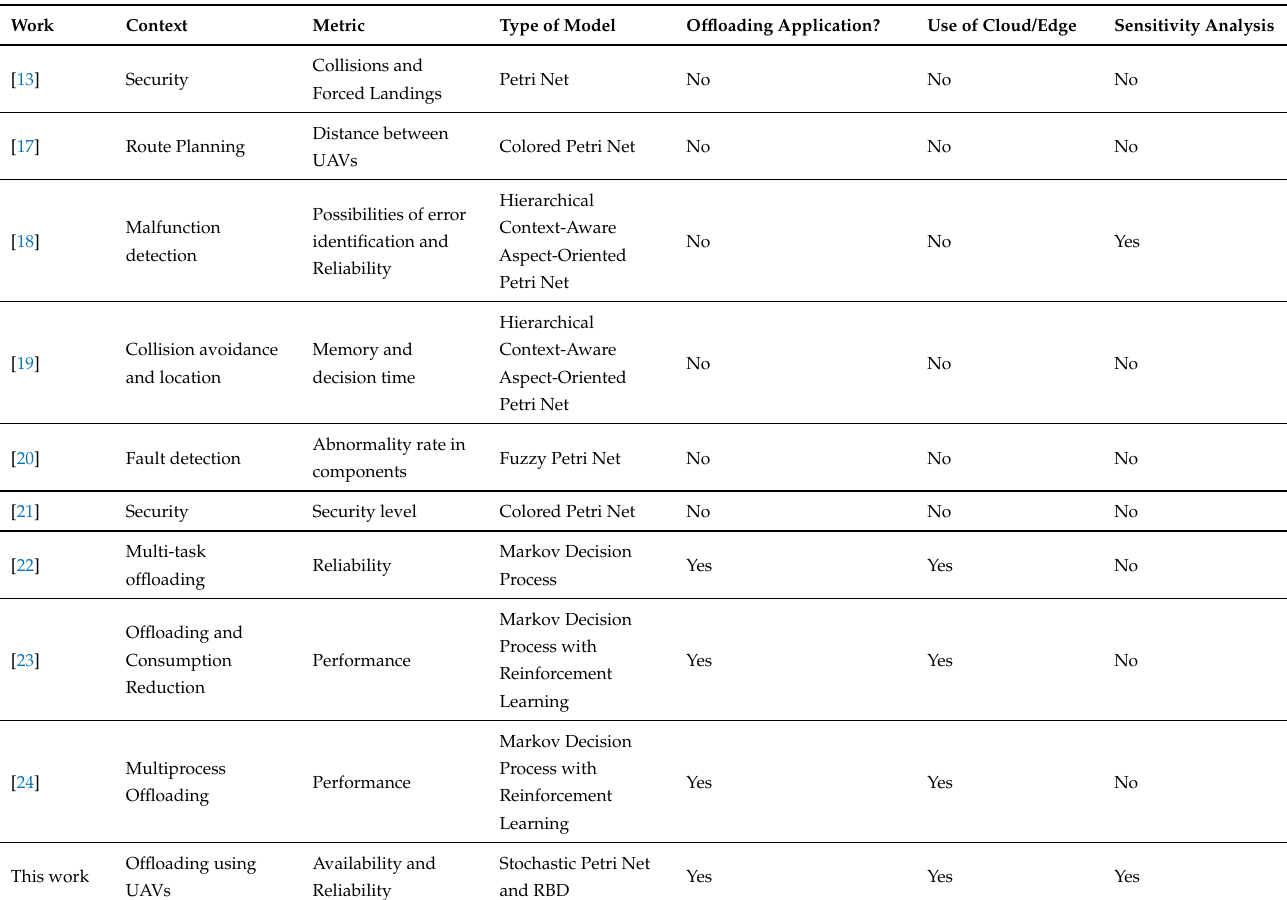
Table 1. Related